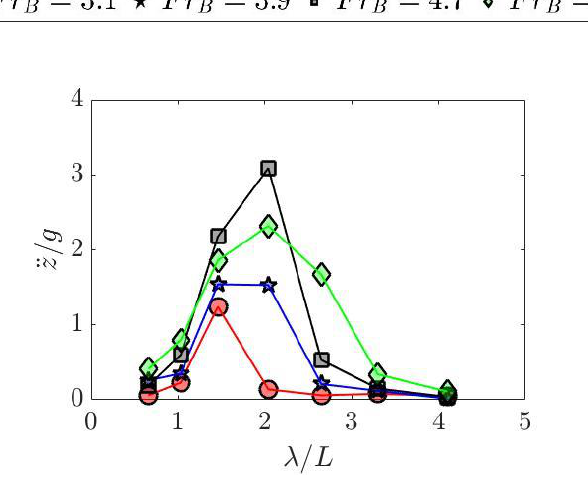
Figure 9. Vertical acceleration of Model B at CG.